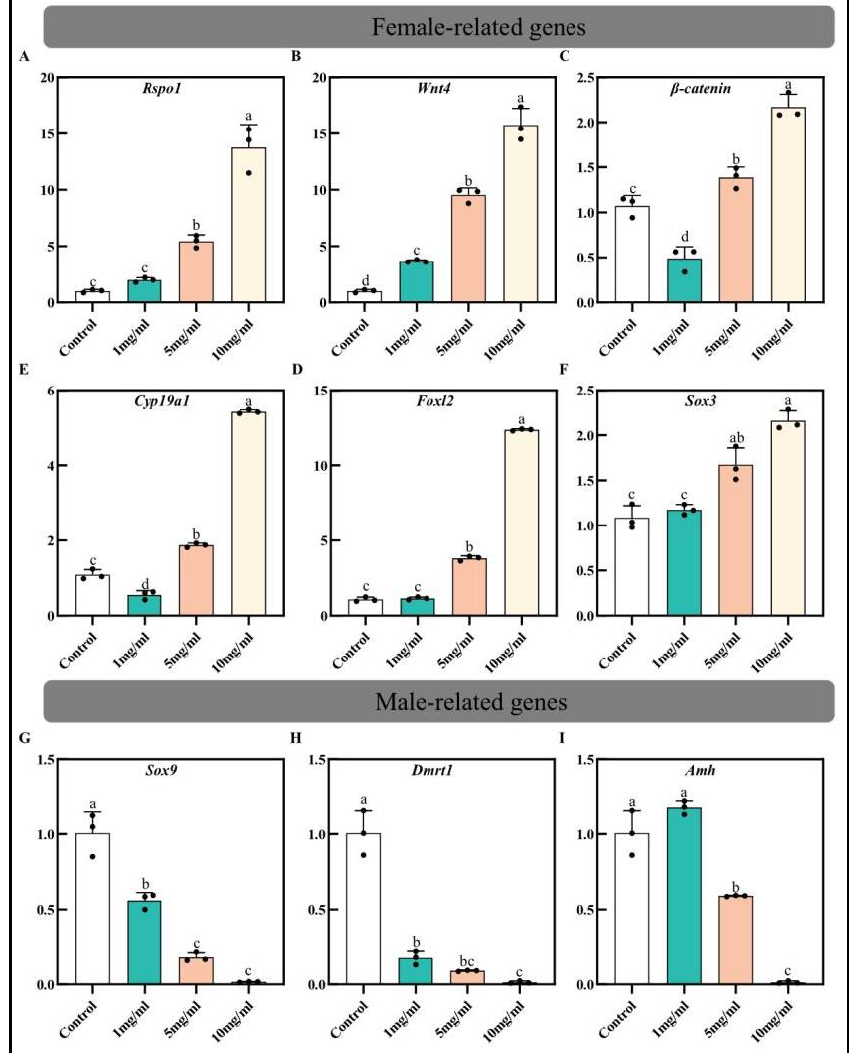
Figure 5. The expressions of sex-related genes at stage 17. Female-related genes: ( A ) Rspo1 ; ( B ) Wnt4 ; ( C ) β -catenin; ( D ) Foxl2; ( E ) Cyp19a1 ; and ( F ) Sox3 . Male-related genes: ( G ) Sox9 . ( H ) Dmrt1 ( I ) Amh . Data are the mean ± SD (n = 3). Significant differences at p < 0.05 are labeled with different letters.